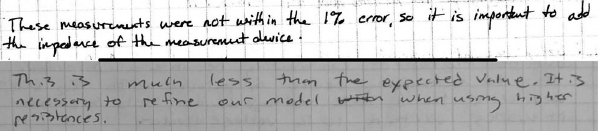
student.FIG. 6. Two examples of documented comparisons for Activity 1. The top example demonstrates the type of quantitative reasoning students used, while the bottom demonstrates the type qualitative reasoning. Note that a proposal to refine the system is also stated in both